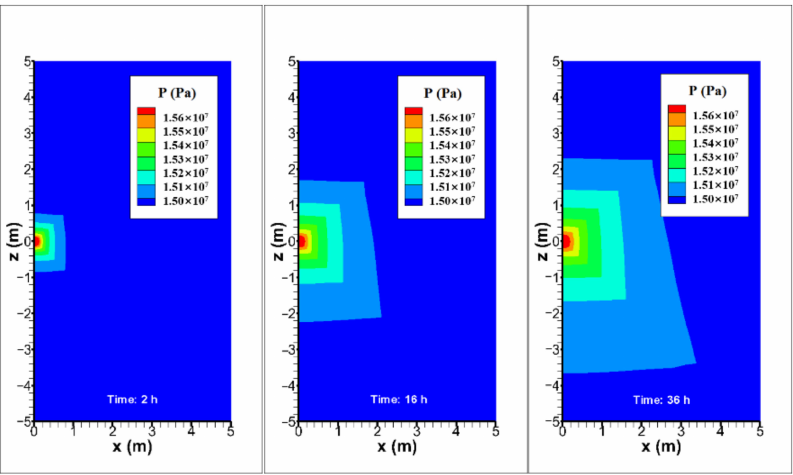
Figure 3. Pore pressure distribution evolution around the wellbore.